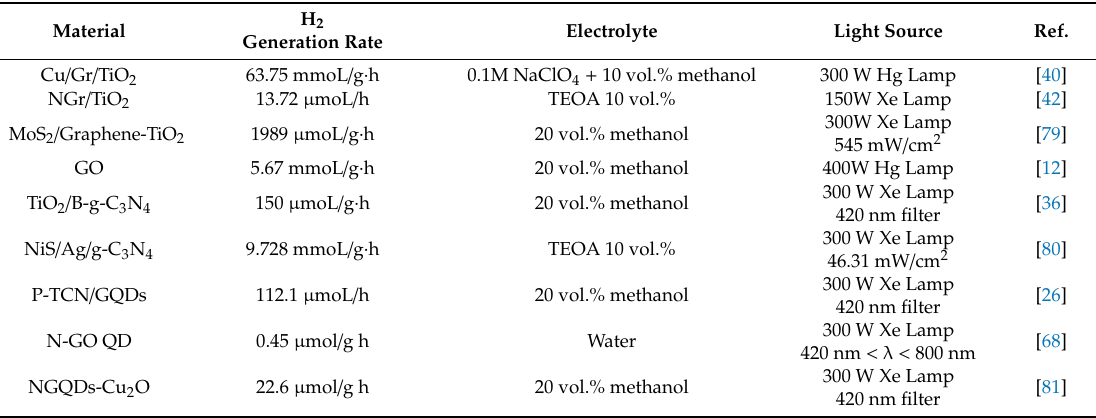
Table 2. Carbon-based photocatalysts for hydrogen